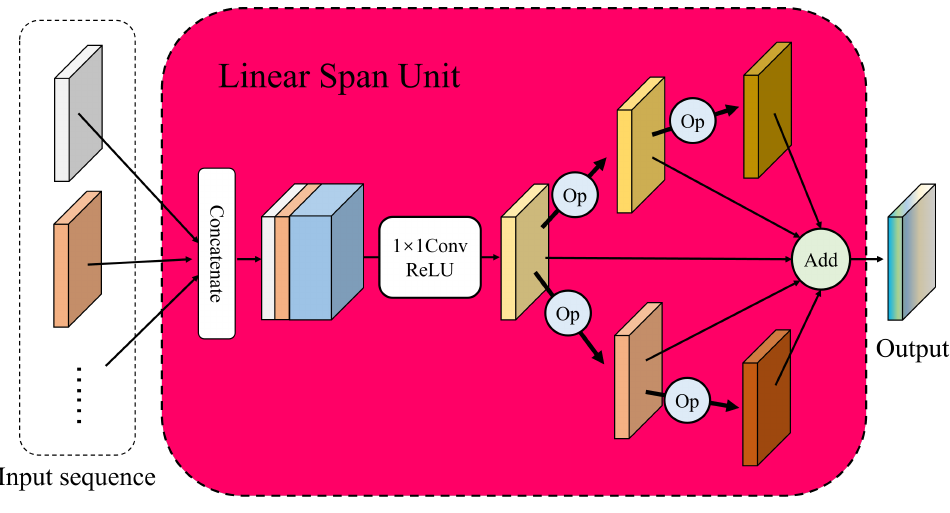
Figure 3. Network structure of linear span unit (LSU).